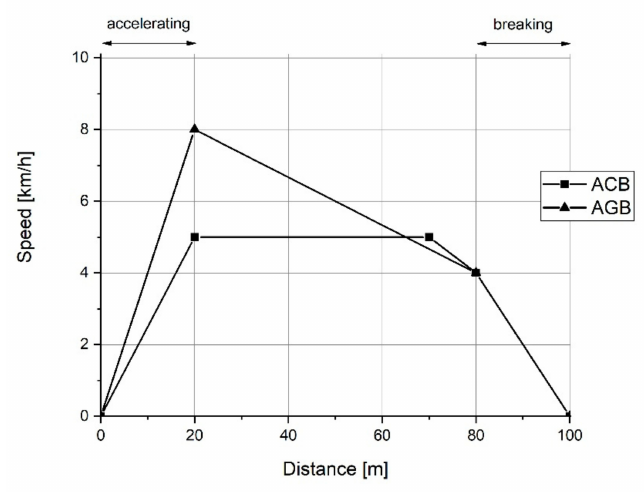
Figure 2. Ferry speed profiles for the two analysed tra ffi c strategies: ACB and